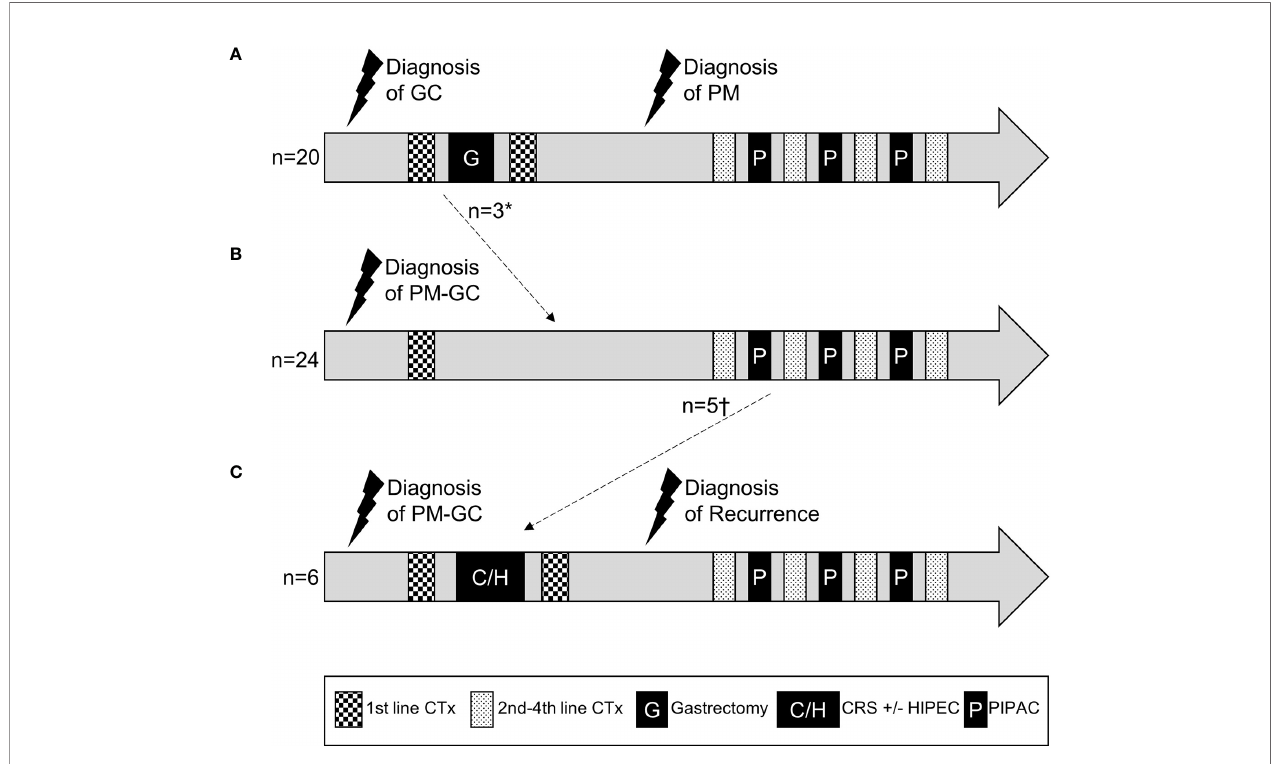
FIGURE 1 | Schematic treatment courses of patients with gastric cancer and metachronous (A) or synchronous (B, C) peritoneal metastasis. Numbers and regimens of chemotherapies and numbers of PIPACs varied between patients and are depicted symbolically. *diagnosis of PM at the time of intended curative gastrectomy, which was then aborted. † patients who received CRS+/ − HIPEC after fi rst or second PIPAC treatment. GC, gastric cancer; PM, peritoneal metastasis; CTx, chemotherapy; CRS, cytoreductive surgery; HIPEC, hyperthermic intraperitoneal chemotherapy; PIPAC, pressurized intraperitoneal aerosol chemotherapy.